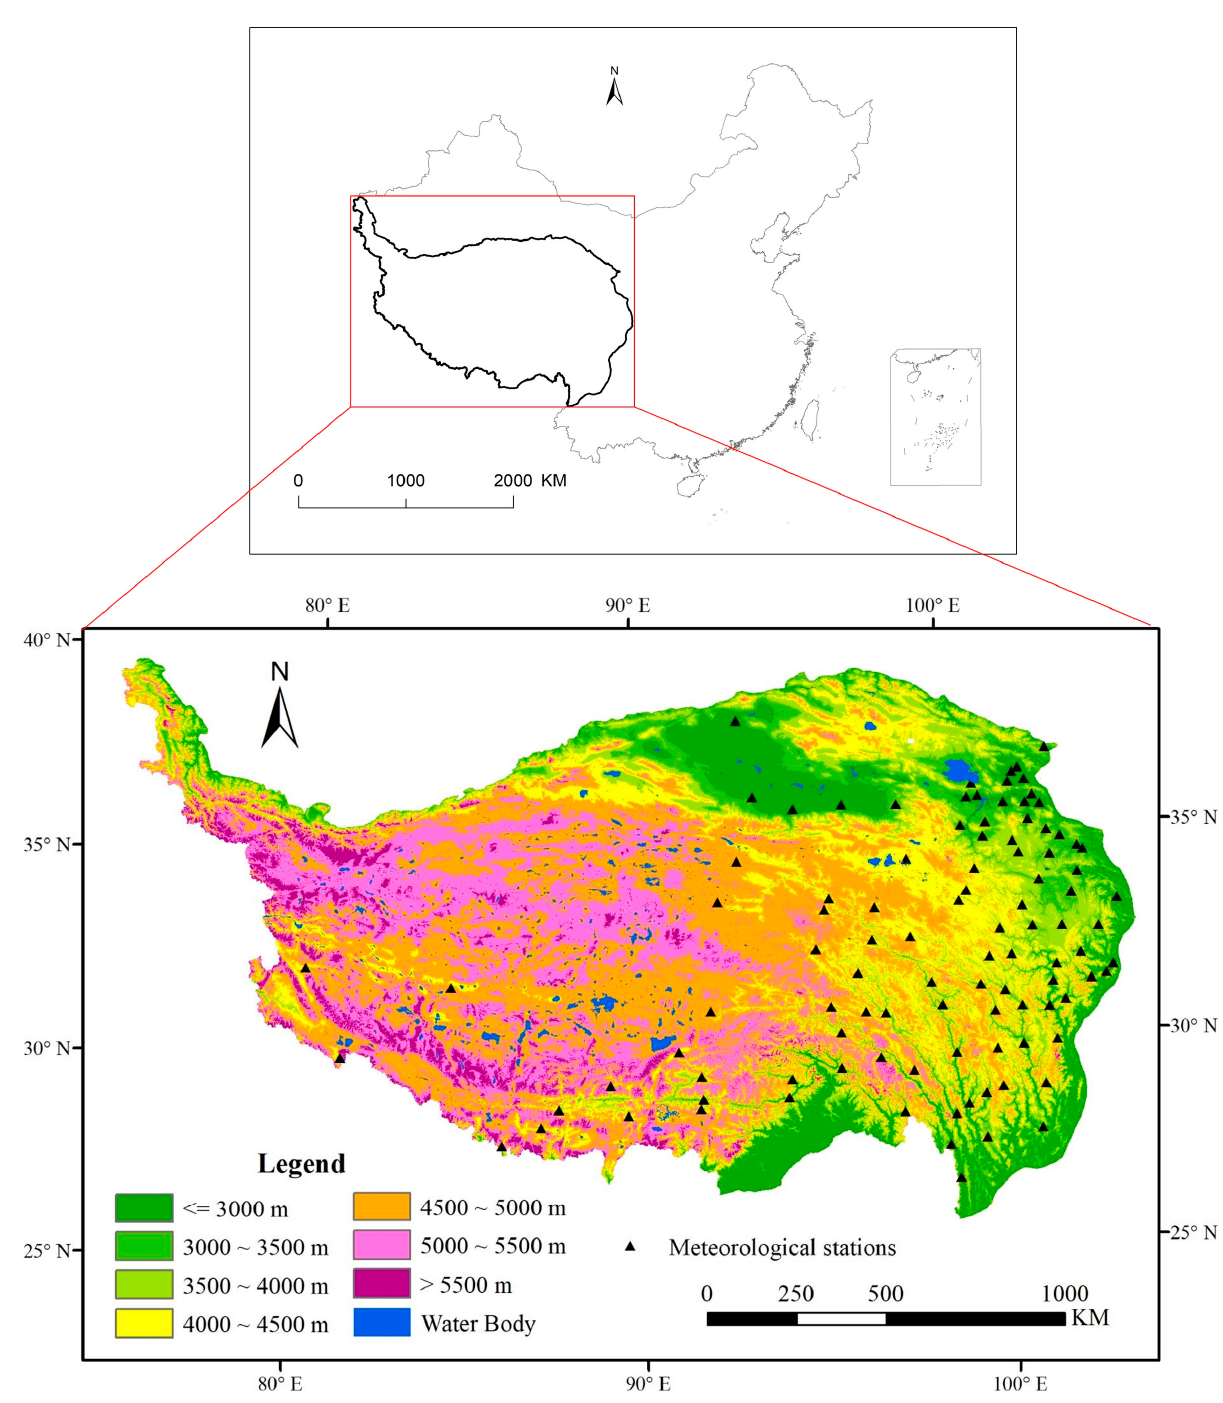
Figure 1. The location of the Qinghai–Tibetan Plateau and spatial distribution of meteorological stations.